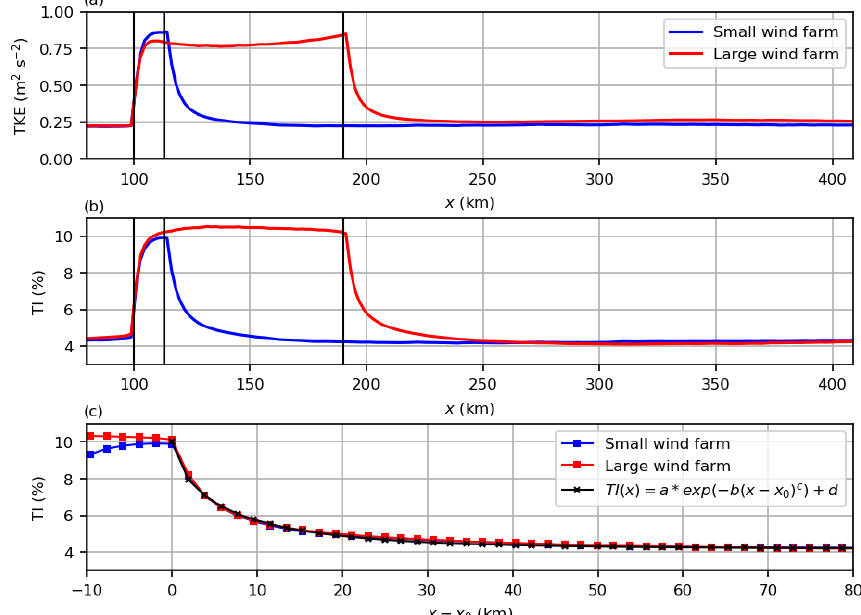
Figure 6. (a) Turbulence kinetic energy (TKE) and (b, c) turbulence intensity (TI) for the small and large wind farm case. The quantities are averaged along y and piecewise along x , with averaging windows centered between the turbine rows. Vertical black lines indicate the wind farm LE and TE of the small and large wind farm. In panel (c) the graphs are shifted by x 0 so that the TE of the small and the large wind farm coincide, where x 0 = x TE + 0 . 5s. Parameters of the fitted curve are a = 5 . 8%, b = 0 . 28km − c , c = 0 . 68 and d = 4 .